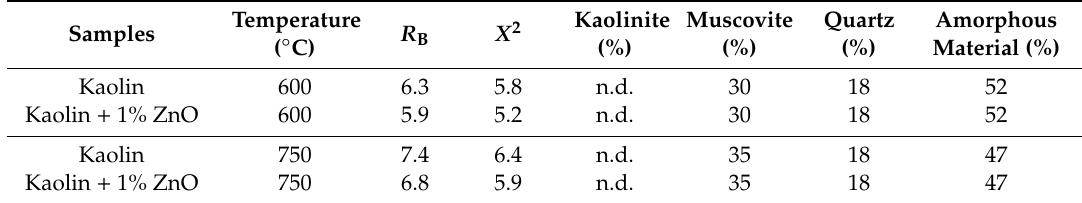
Table 4. Rietveld quantification of kaolin + 1% ZnO.